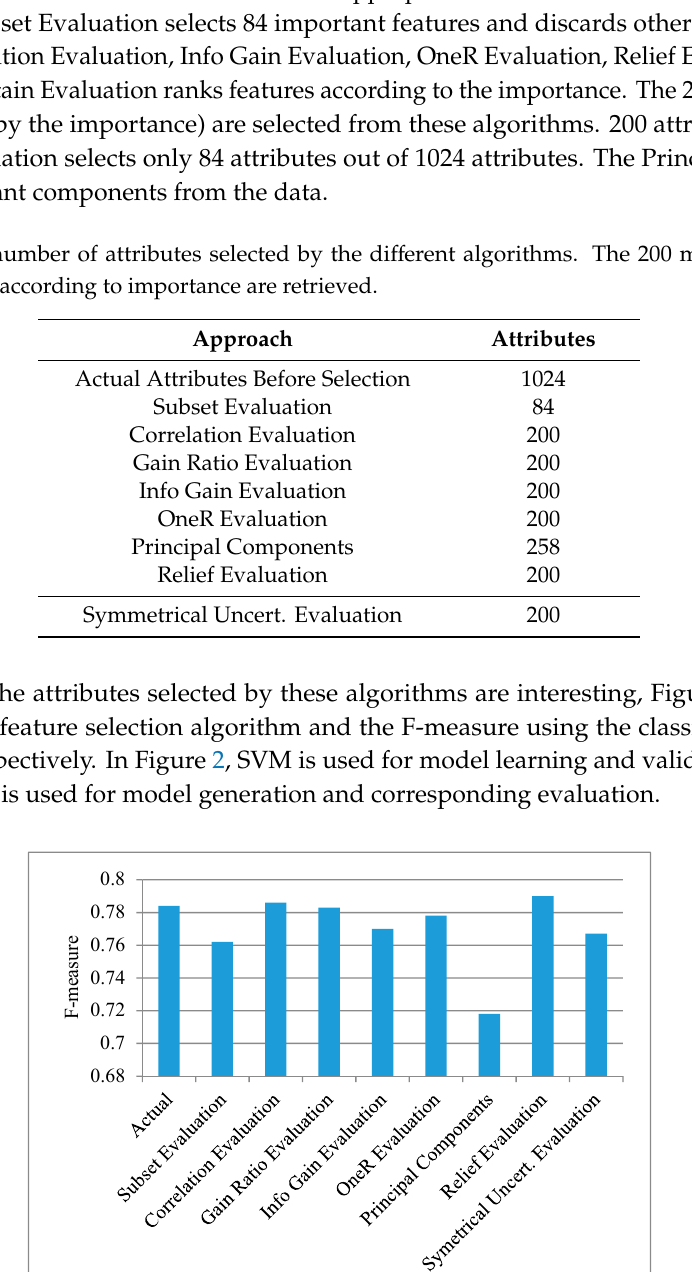
Figure 3. Random Forest performance based on the F-measure for the Actual 1024 attributes and the F-measure based on the attributes selected by the corresponding algorithm.